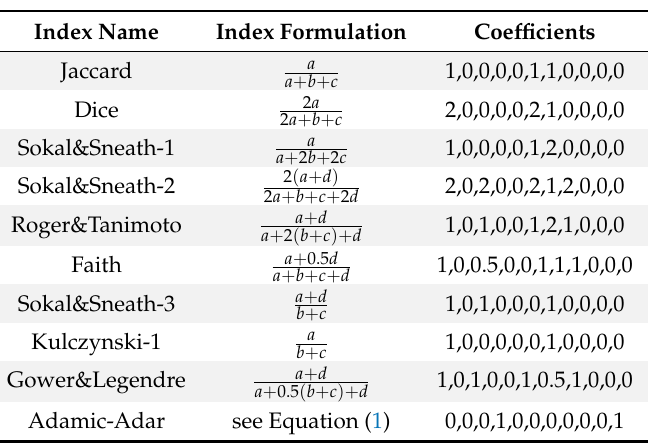
Table 1. µ 1 subsumed